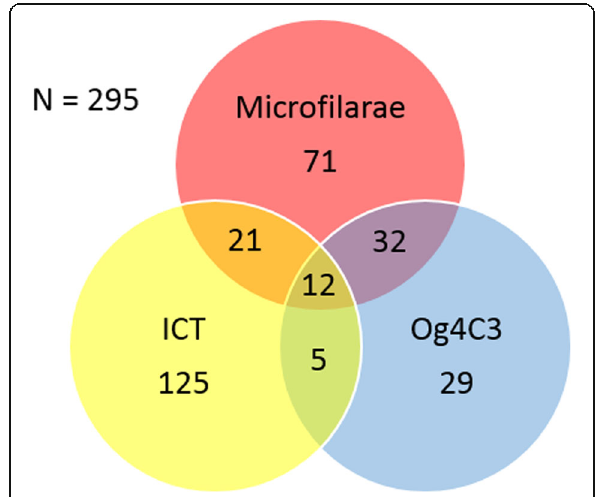
Fig. 1 Distribution of diagnostic tests utilised by the surveys included. Values represent the number of surveys that utilised a specific diagnostic or combination of